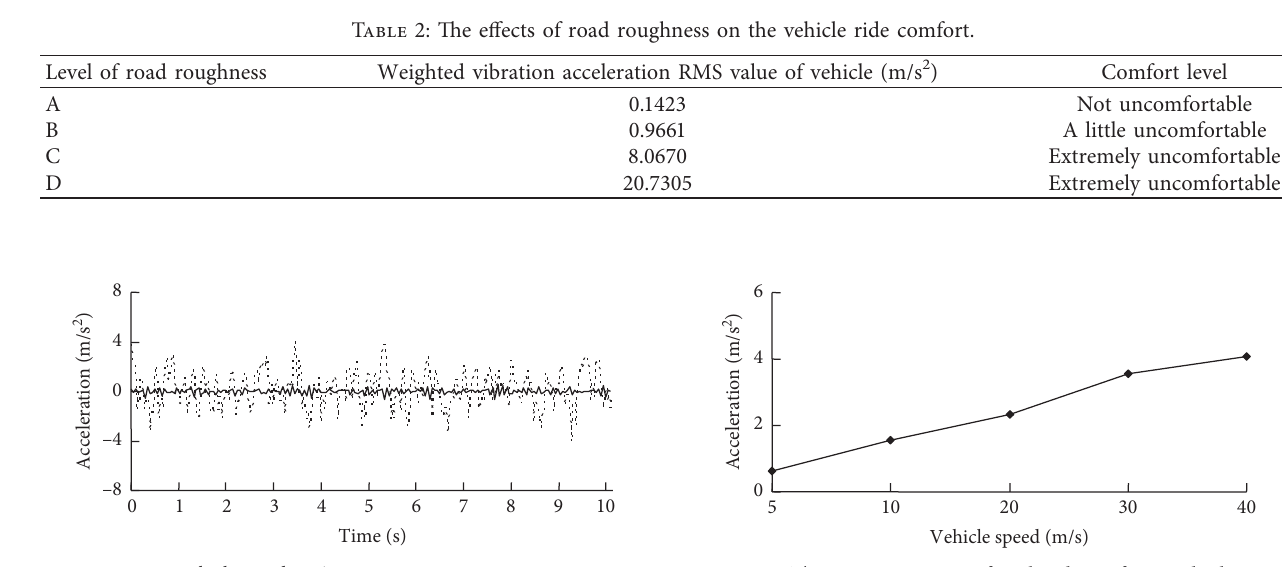
Figure 18: The variation curve of peak values of vertical vibration accelerations of the vehicle body.